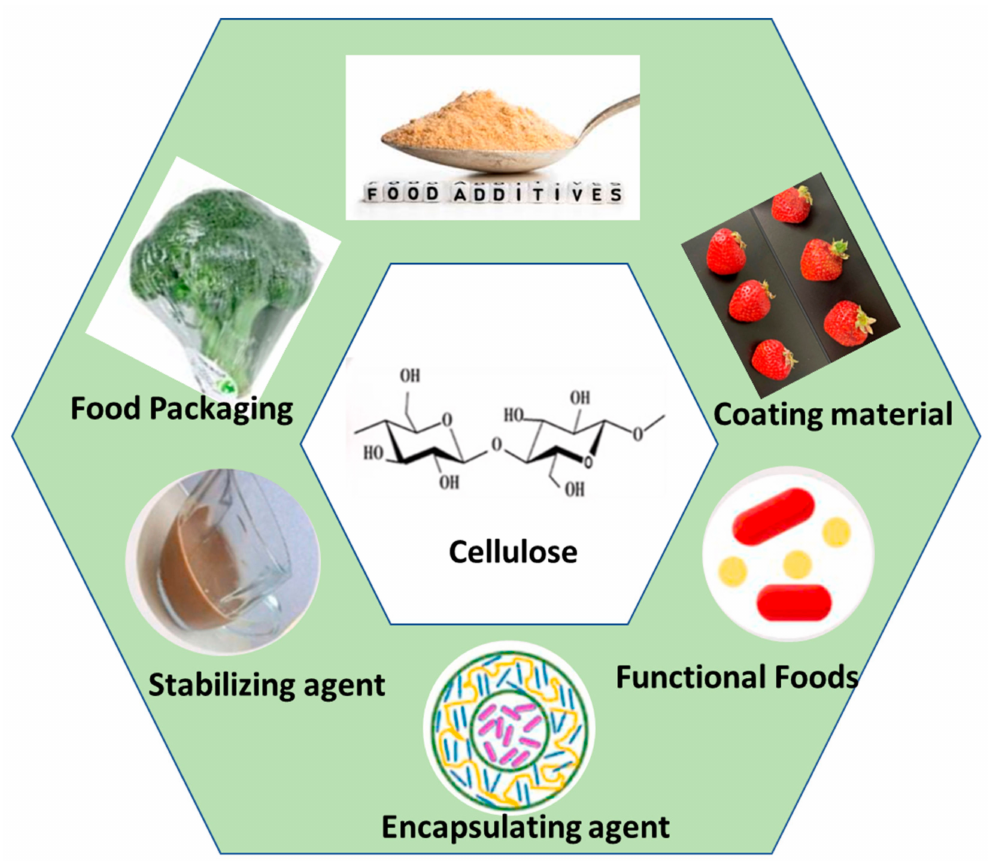
Figure 3. Bacterial cellulose applications in the food industry and as food packaging materials. Figure reproduced from [108], with permission from the